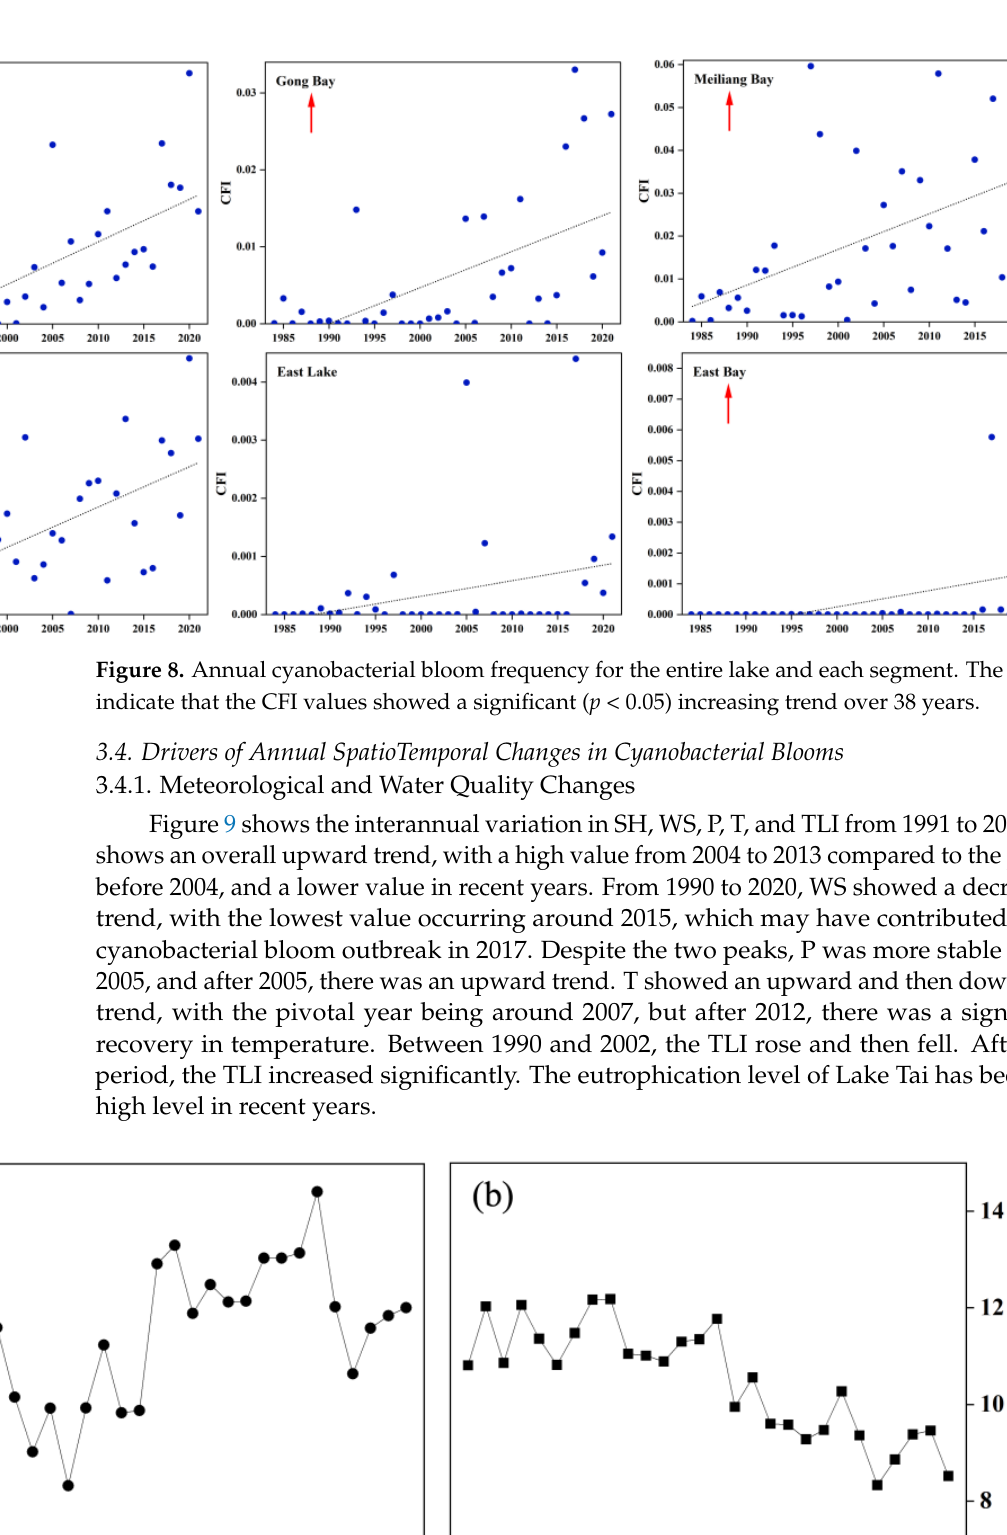
Figure 9. Interannual change in ( a ) annual sunshine hours (SH); ( b ) annual maximum wind speed (WS); ( c ) annual precipitation (P); ( d ) annual mean temperature (T); ( e ) comprehensive trophic level index (TLI) during 1991 – 2018 in Taihu Lake. 3.4.2. Influence of Individual Meteorological or Water Quality Factor The influences of individual meteorological or water quality factors on the interan- nual characteristics (CAP and CFI) of the cyanobacterial blooms in Taihu Lake were de- termined via the Spearman correlation coefficient (Figure 10). The TLI had a highly sig- nificant positive correlation with CAP and CFI ( p < 0.01); the correlation coefficients were 0.56 and 0.57, respectively. SH was significantly positively correlated with CAP and CFI ( p < 0.05); the correlation coefficients were 0.45 and 0.42, respectively. T was positively correlated with CAP and CFI; the correlation coefficients were 0.36 and 0.42, respectively. P was associated with CAP and CFI, showing a weak positive correlation, and the corre- lation coefficients were 0.014, 5.5 × 10 −4 , respectively. In contrast, WS had a highly signifi- cant negative correlation with CAP and CFI ( p < 0.001), and the correlation coefficients were − 0.64 and 0.60, respectively. In terms of the absolute values of the correlation coeffi- cients, the influence of TLI and WS on cyanobacterial blooms was greater than that of other factors.